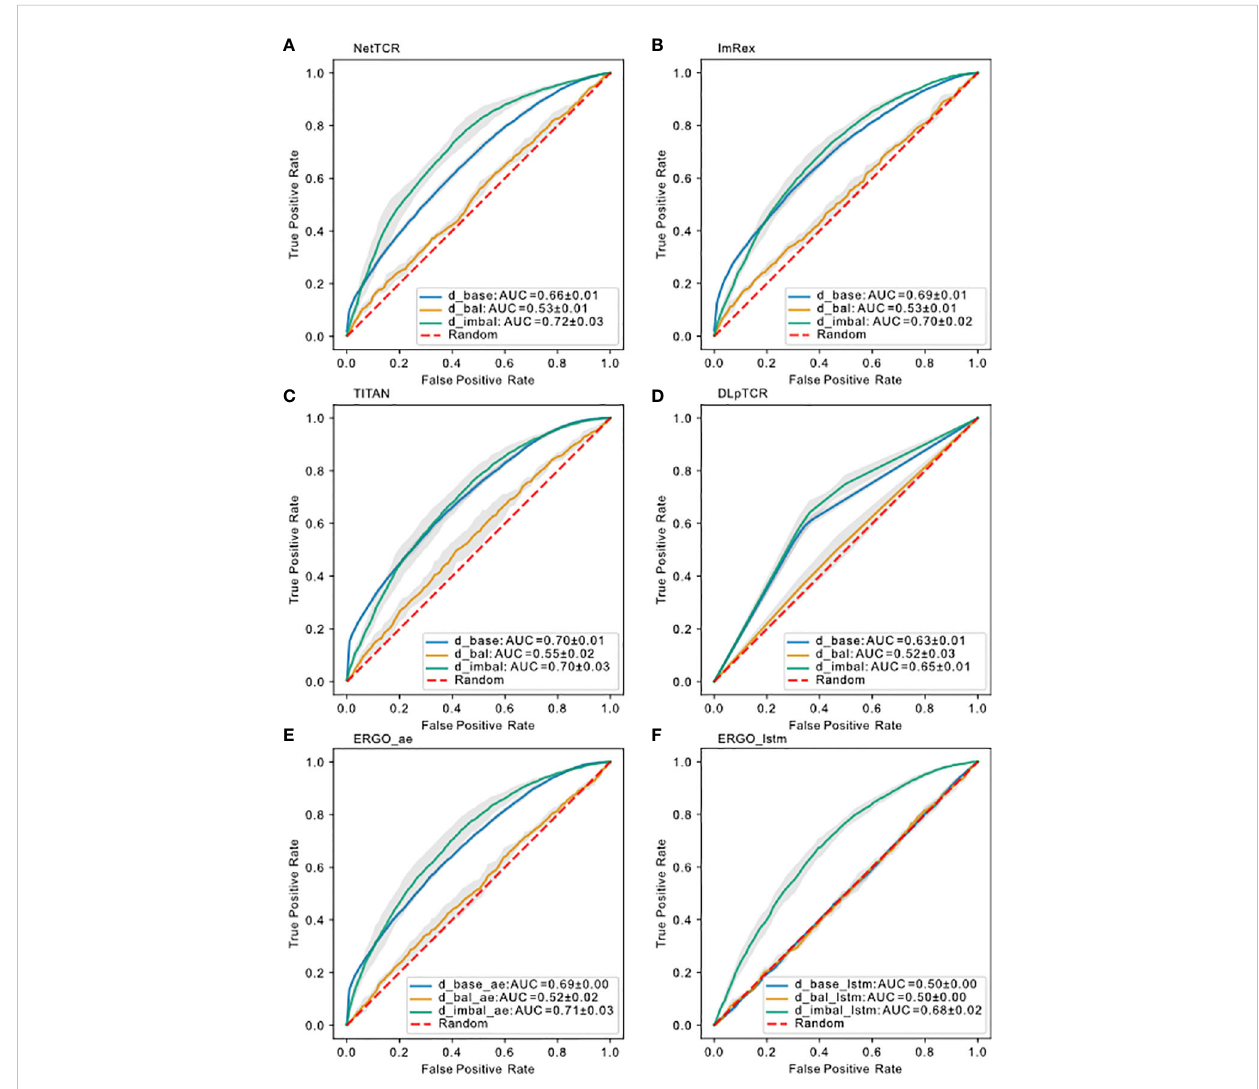
FIGURE 6 Model performance on different datasets using uniform splitting. ROC curve for (A) NetTCR-2.0, (B) ImRex, (C) TITAN, (D) DLpTCR (Curves looks “ linear ” , because DLpTCR outputs a binary and not a continuous probability), (E) ERGO Autoencoder model and (F) ERGO LSTM model using d base , d bal and d imbal . The dashed red diagonal line indicates performance for random